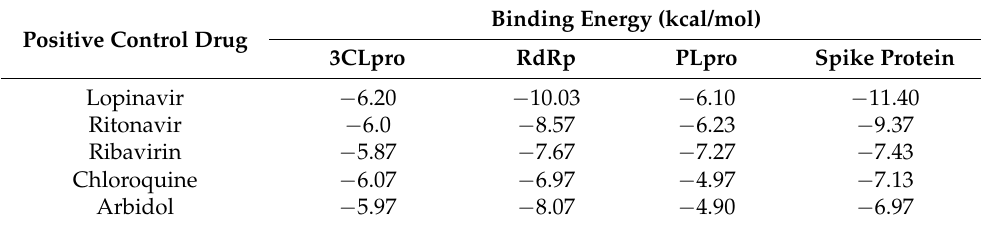
Table 2. Molecular docking results of positive control drug. Positive Control